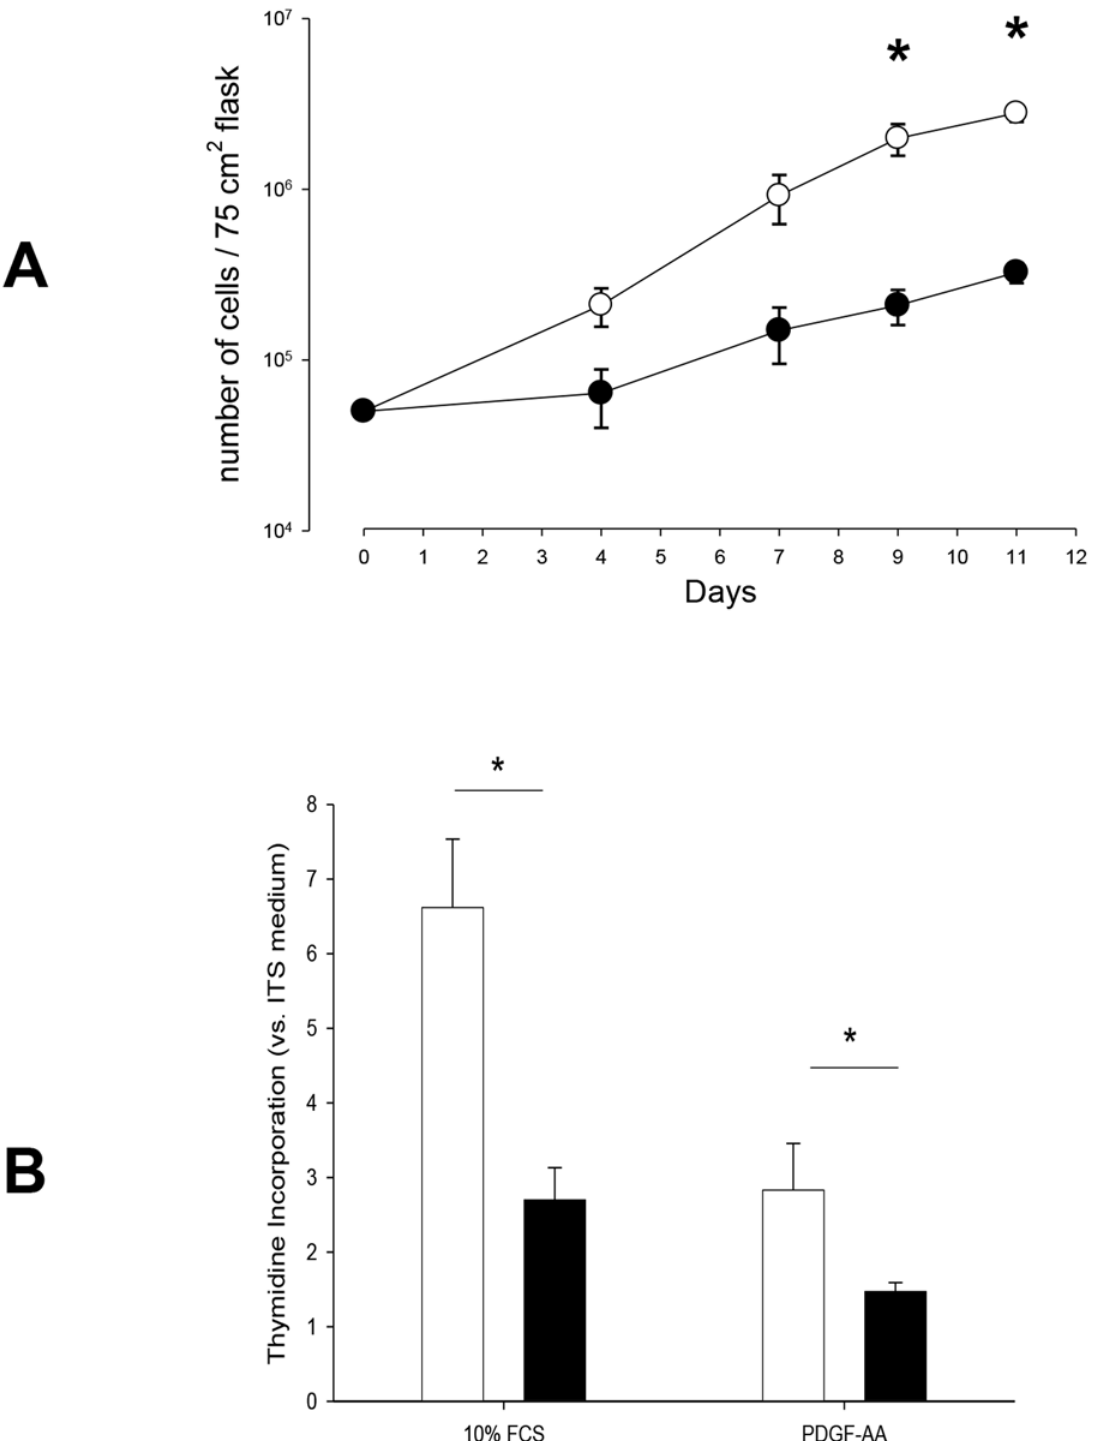
Fig 1. Proliferation of neonatal and adult cultured human airway smooth muscle cells in the presence of FCS and PDGF-AA. A. Cell counts according to time. Results are means ± SEM. In glucose + 10% FCS medium, ASMC proliferation was greater in neonatal cells (open symbols, n = 5) vs. adult cells (closed symbols, n = 5). * p < 0.05 neonate vs. adult at the corresponding time using MANOVA. B. DNA synthesis in adult and neonatal cultured human airway smooth muscle cells. Results are means ± SEM. Values were normalized to proliferation in ITS medium. Cells cultured in 10% FCS (white bars, neonates, n = 5; black bars, adults, n = 7)), 15 ng/ml PDGF-AA (neonate, n = 4; adults, n = 10). * p < 0.05 using Mann-Whitney U-test.